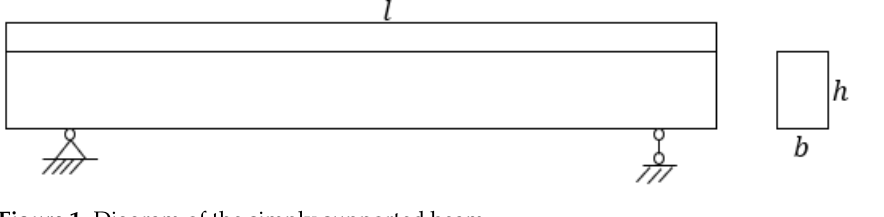
Figure 1. Diagram of the simply supported beam.